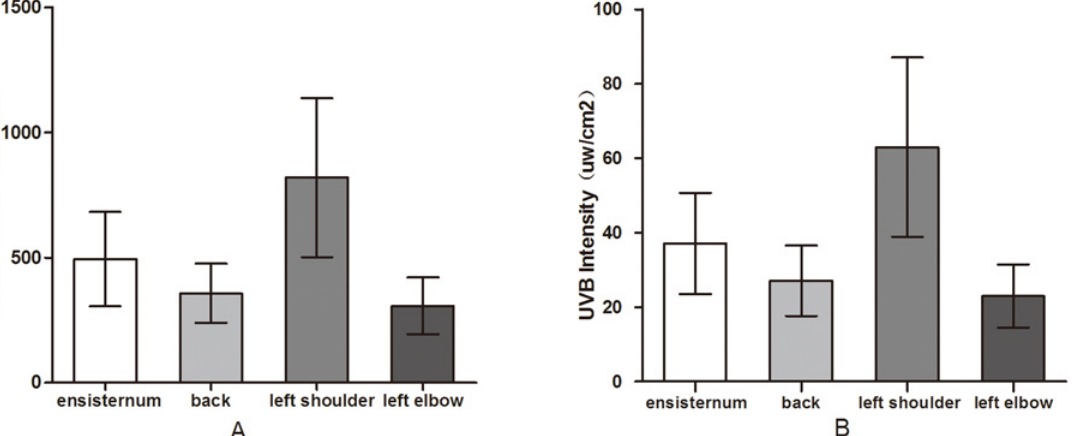
Fig 9. Ultraviolet light intensity at different anatomical sites. Although the back and the left elbow showed no significant differences in exposure to ultraviolet light, there were significant differences in the UVA and UVB intensities experienced at the four anatomical